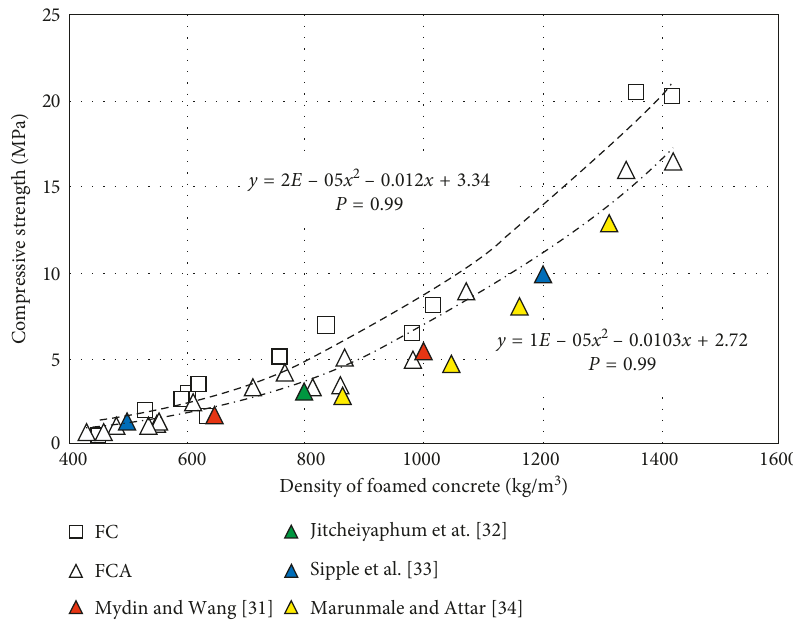
Figure 3: Compressive strengths of foamed concrete FC and FCA as a function of density of foamed concrete.